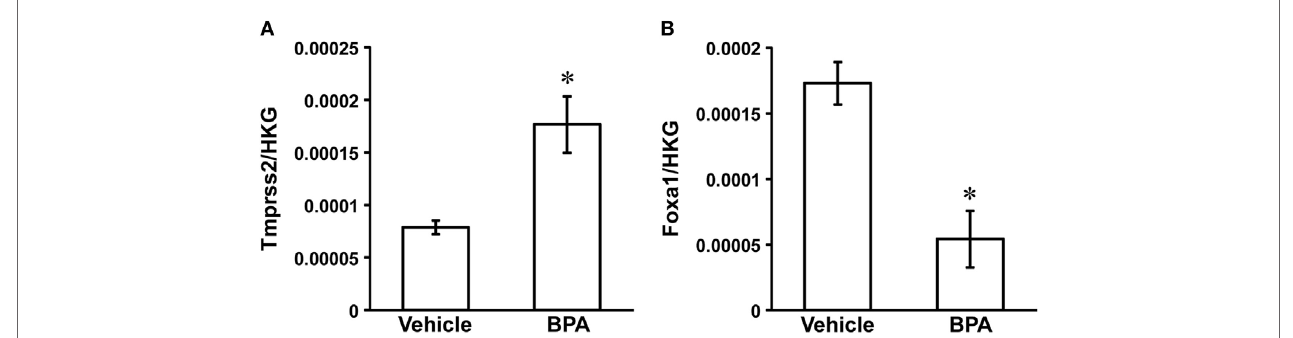
FigUre 1 | Effect of Bisphenol A (BPA) administration on Tmprss2 and Foxa1 gene expression in the neonatal male rat medial amygdala. (a) Effect of BPA administration on the ratio of Tmprss2 gene expression level relative to housekeeping gene (HKG). Each column and the vertical line represent the mean ± SEM ( n = 3 samples, both sides of medial amygdala of two male siblings in one sample). * P < 0.05, vehicle vs. BPA by Student’s t -test. (b) Effect of BPA administration on the ratio of Foxa1 gene expression level relative to HKG. Each column and the vertical line represent the mean ± SEM ( n = 3 samples, both sides of medial amygdala of two male siblings in one sample). * P < 0.05, vehicle vs. BPA by Student’s t